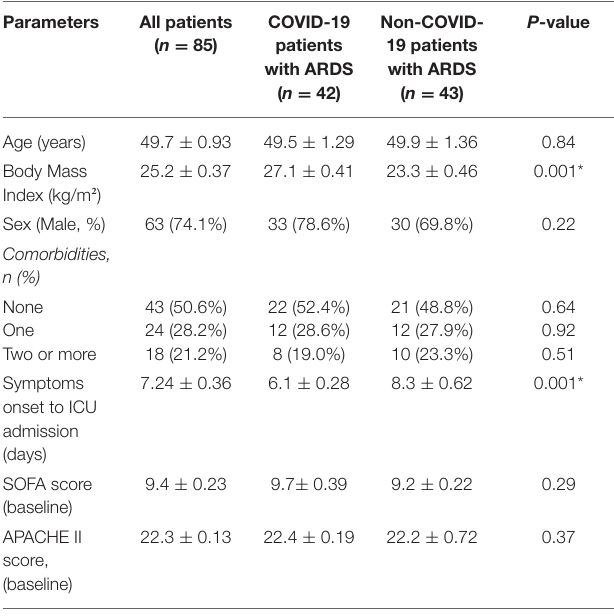
TABLE 1 | Characteristics of forty-two COVID-19 patients and forty-three patients without COVID-19 and with acute respiratory distress syndrome.